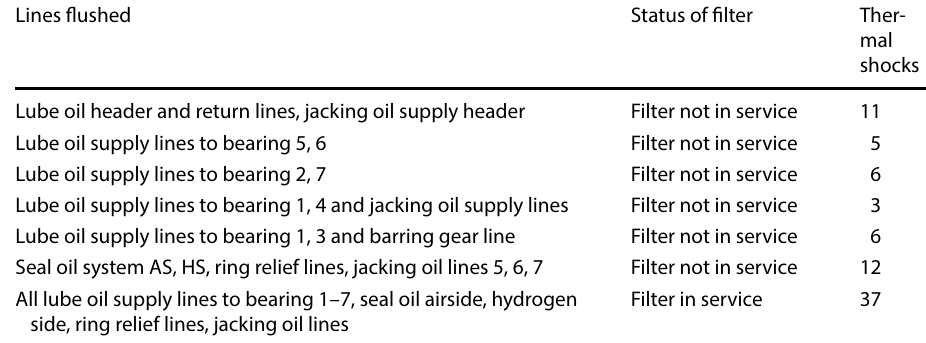
Table 1 Stage-2 Flushing data Lines flushed Status of filter Ther- for thermal shocks